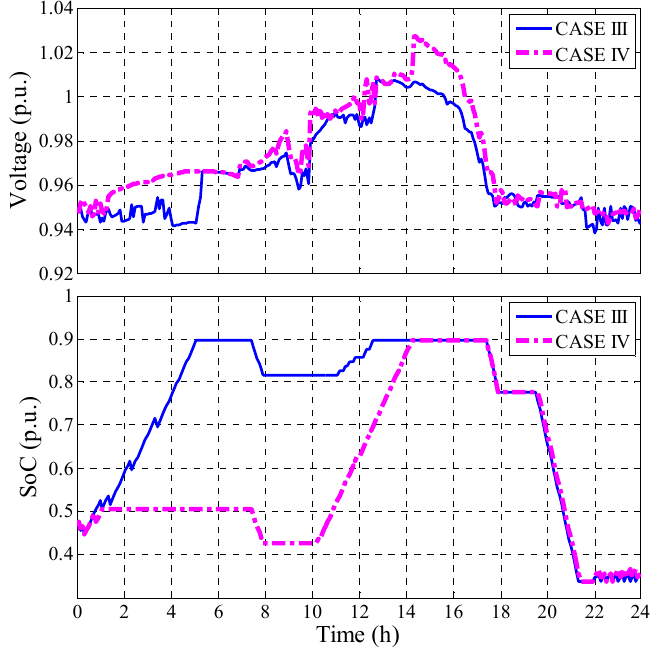
Figure 9. Voltage profile and SoC for bus 10: CASE III and CASE IV.